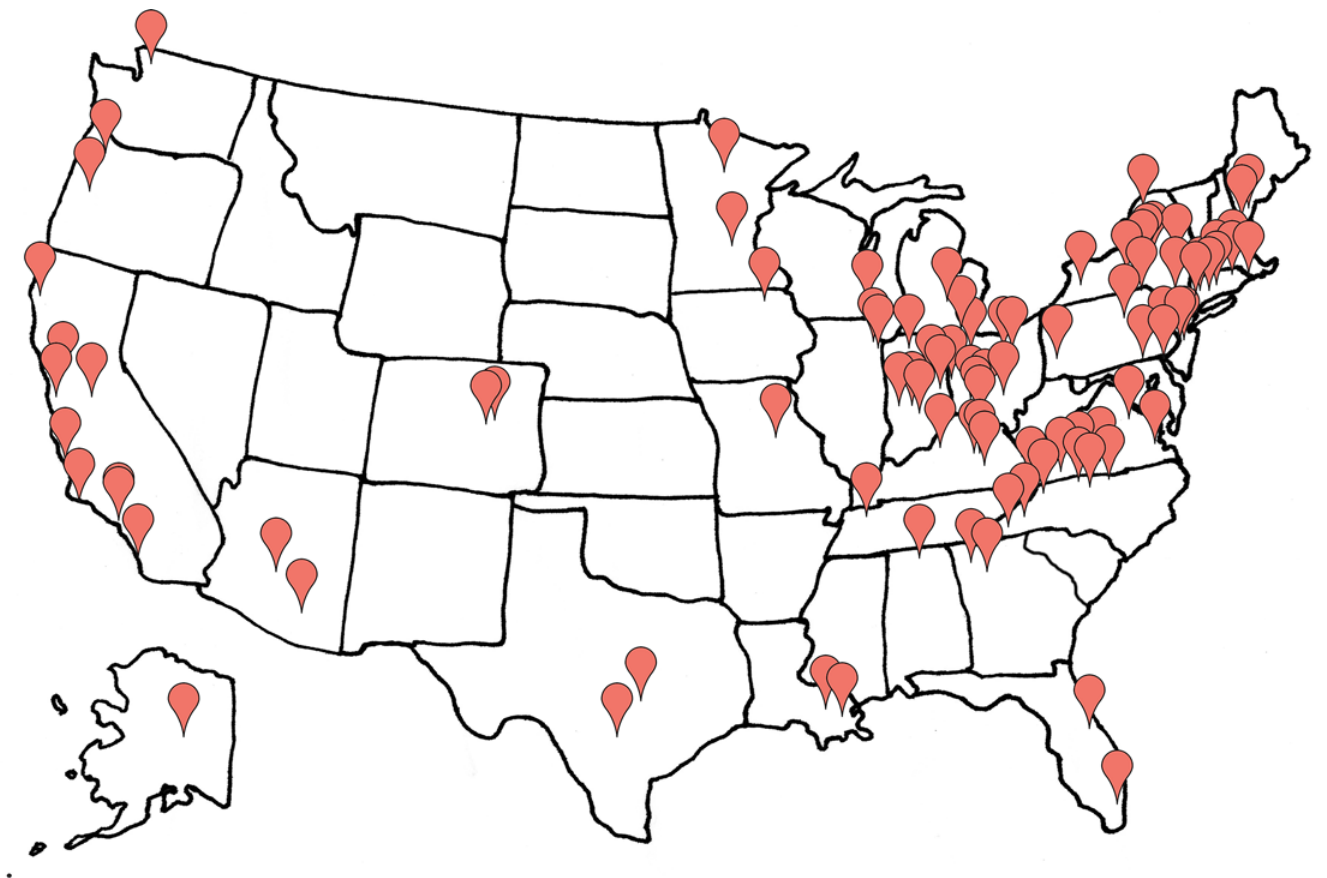
Fig 1. Geographic distribution of schools that participated in the fall 2012